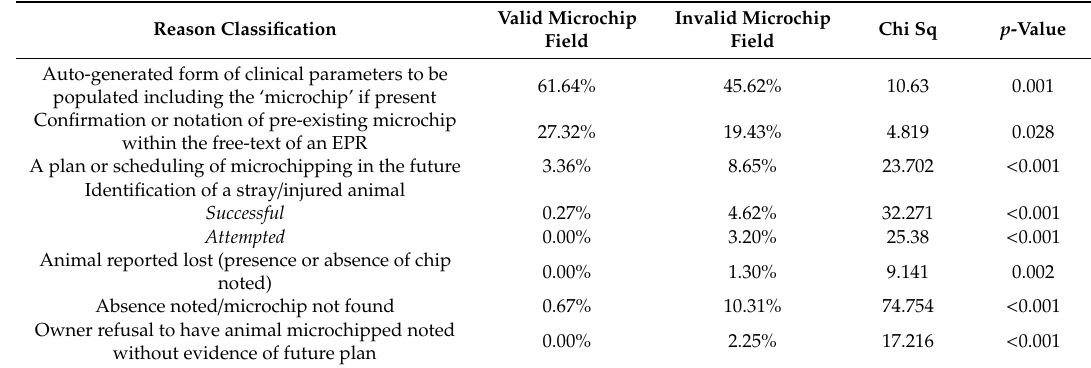
Table 1. Comparison of reasons for a positive search result that did not represent a microchip implantation event between Valid Microchip Field cohort and Invalid Microchip field cohort. Reason Classification